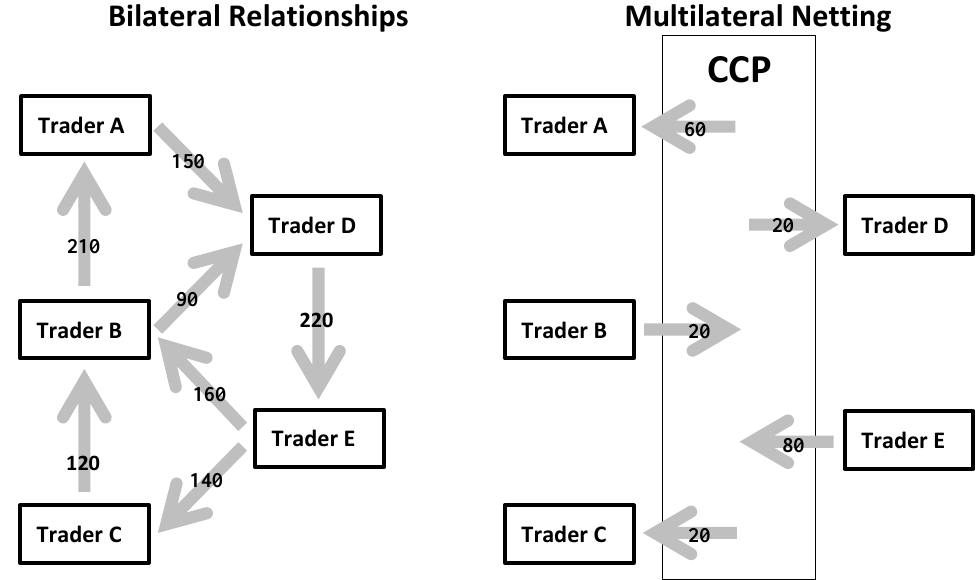
Figure 4. Bilateral trading relationships and multilateral netting. The figure shows trading rela- tionships among five traders, named A, B, C, D and E. The graph on the left shows their bilateral relationships. The arrows represent the cash flows (bonds flow in the opposite direction). The number attached to the arrow represents the value of the bonds exchanged. The graph on the right illustrates multilateral netting. The CCP is the counterparty for each trader. The traders just receive or deliver the netted amount to the